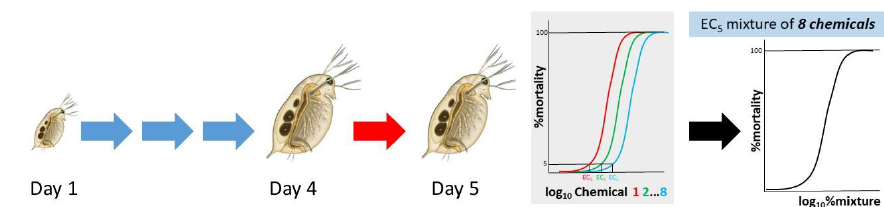
Figure 1. Experimental design. Four-day-old daphnids were exposed to eight chemicals individually for 24 h. Description of the combined mixture effect at EC 5 was used to assess its toxicity at 24 h.